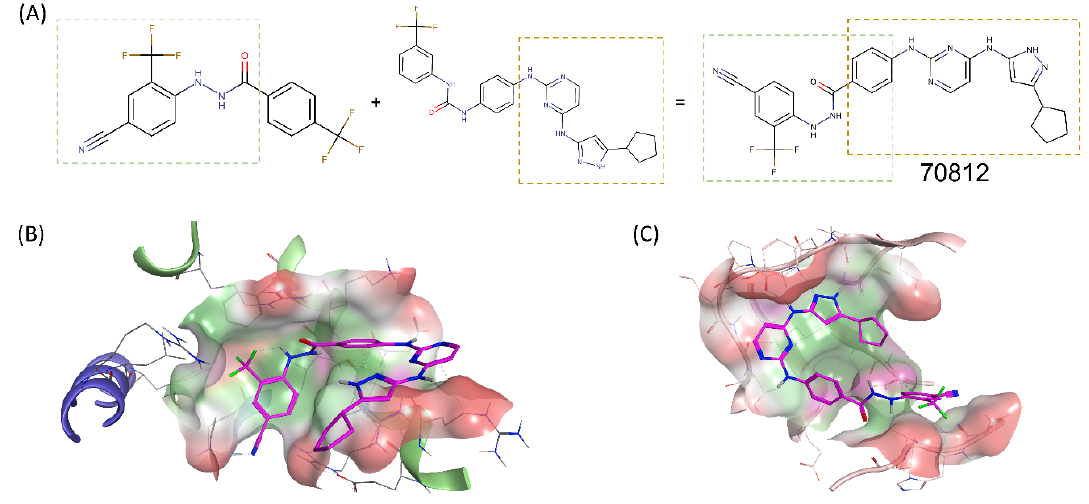
Figure 3. Merging of 70551’s scaffold with CD532’s scaffold for a novel dual-inhibitor. ( A ) The N-Myc specific scaffold, 70551 (left), shared a similar core with the AURKA specific scaffold, CD532 (right). Enclosed in green and yellow boxes are the sections of each scaffold responsible for the compounds’ inhibitory activity in their respective targets. The active parts of each scaffolds were merged by a commonly shared unsubstituted phenyl ring to generate 70812. ( B ) In N-Myc, 70812 (magenta sticks) has the critical H-bond with the backbone O of Arg215 of Max to maintain the scaffold in place in the DBD pocket. 70812’s tail is flipped towards the N-terminus of the DBD. ( C ) In AURKA, 70812 is docked in the ATP-binding core of AURKA and is tuck snuggly in the same position as CD532 in the AURKA pocket. Hydrophobic surface: green, polar surface: pink, and exposed surface: red. The beta-sheets have been removed for easier visualization of AURKA’s proposed binding site.